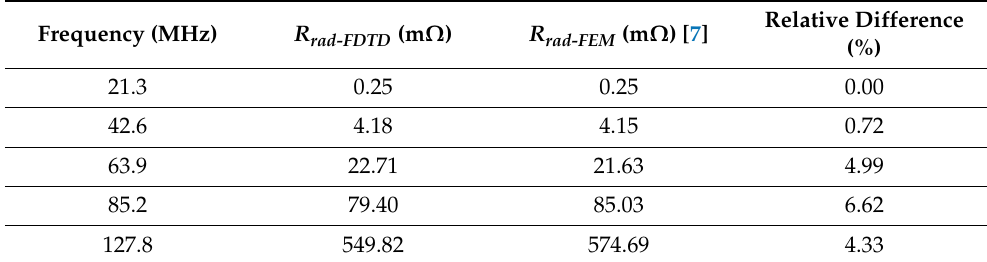
Table 2. Coil radiation resistance estimation for different frequencies (non-segmented loop). FDTD and FEM calculation results.